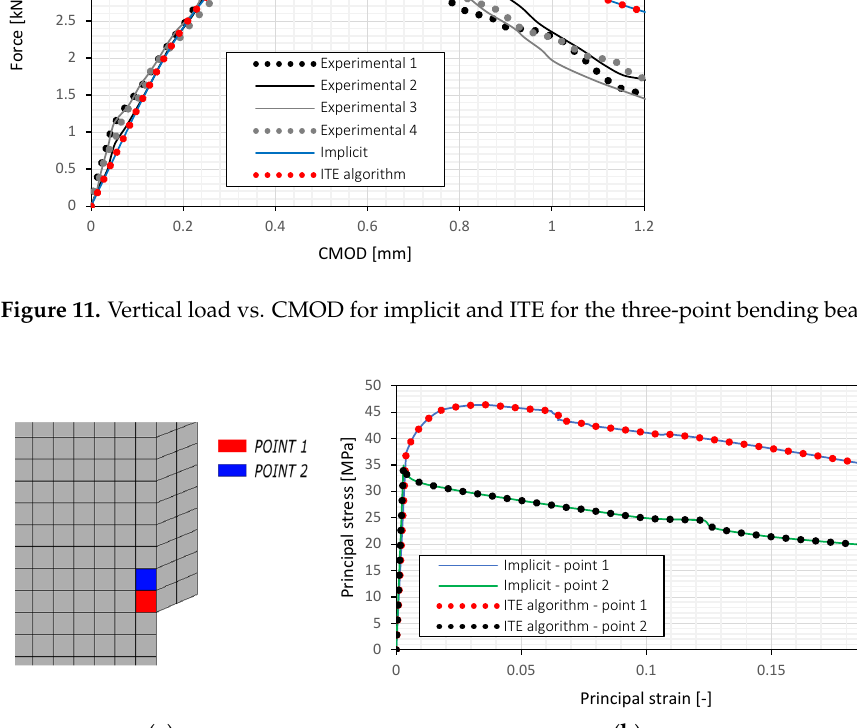
Figure 12. Identification of integration points 1 and 2 ( a ) and distribution of principal stress vs. prin- cipal strain ( b ) for the three-point bending beam.